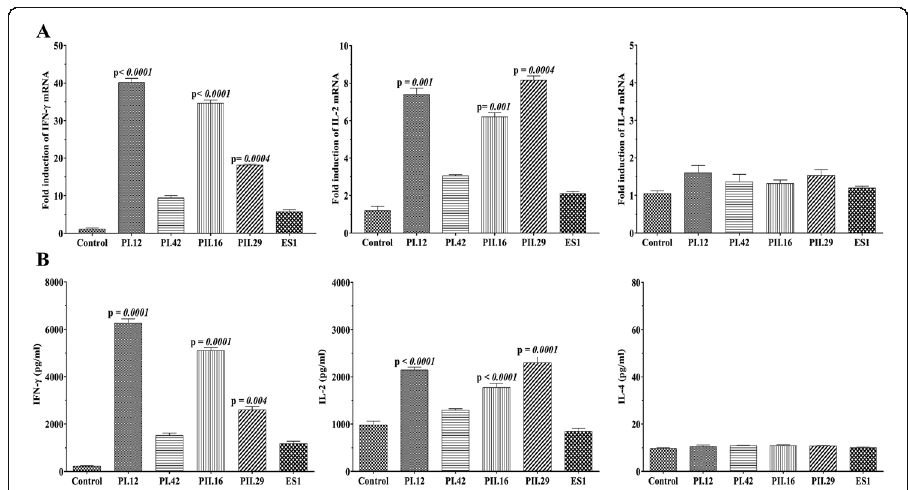
Fig. 5 Cytokine mRNA expression and enhanced IFN- γ and IL-2 production in T cells treated with anti-4- 1BB scFvs. a Following 72 h of treatment with anti-4-1BB scFvs, cells were collected and analyzed for IFN- γ , IL-2 and IL-4 mRNA expression levels using real-time PCR, with the amplification normalized against HPRT. Results from quantitative real-time PCR demonstrate that mRNA for IFN- γ and IL-2 was significantly increased in T cells treated with PI.12, PII.16 and PII.29 scFvs.PI.42 and that ES1 scFvs could not induce IFN- γ and IL-2 production in T cells. No IL-4 mRNA expression was observed in the treated cells. NS: no significant difference. * p < 0.05. Data represent the mean of three experiments ± SD. b Cytokine secretion by T-cells treated with anti-4-1BB scFvs was determined using ELISA. IFN- γ and IL-2 increased significantly following treatment of T cells with PI.12, PII.16 and PII.29 scFvs ( p < 0.05), while the increase in IL-4 production